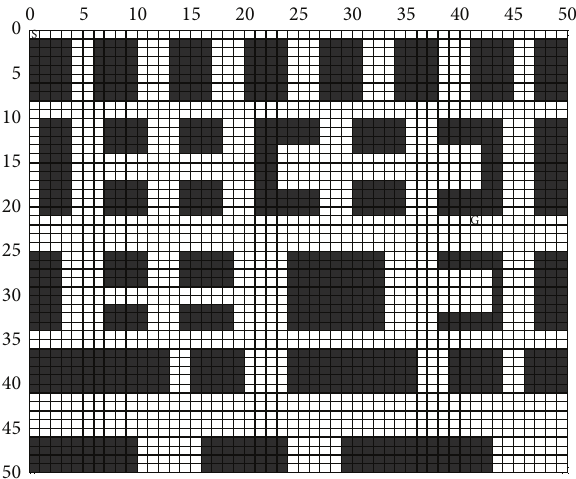
Figure 16: The working environment map